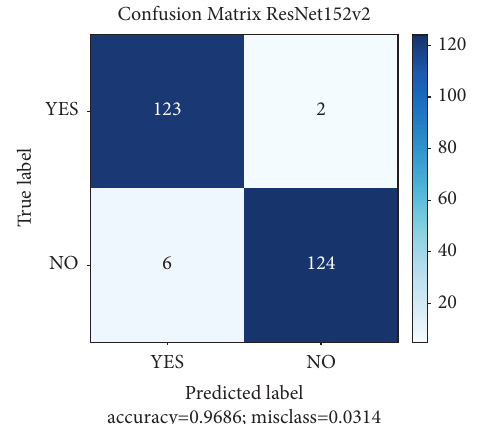
Figure 23: Accuracy evaluation matrix of ResNet152V2 network architecture using ADAS optimization algorithm via F1-score.